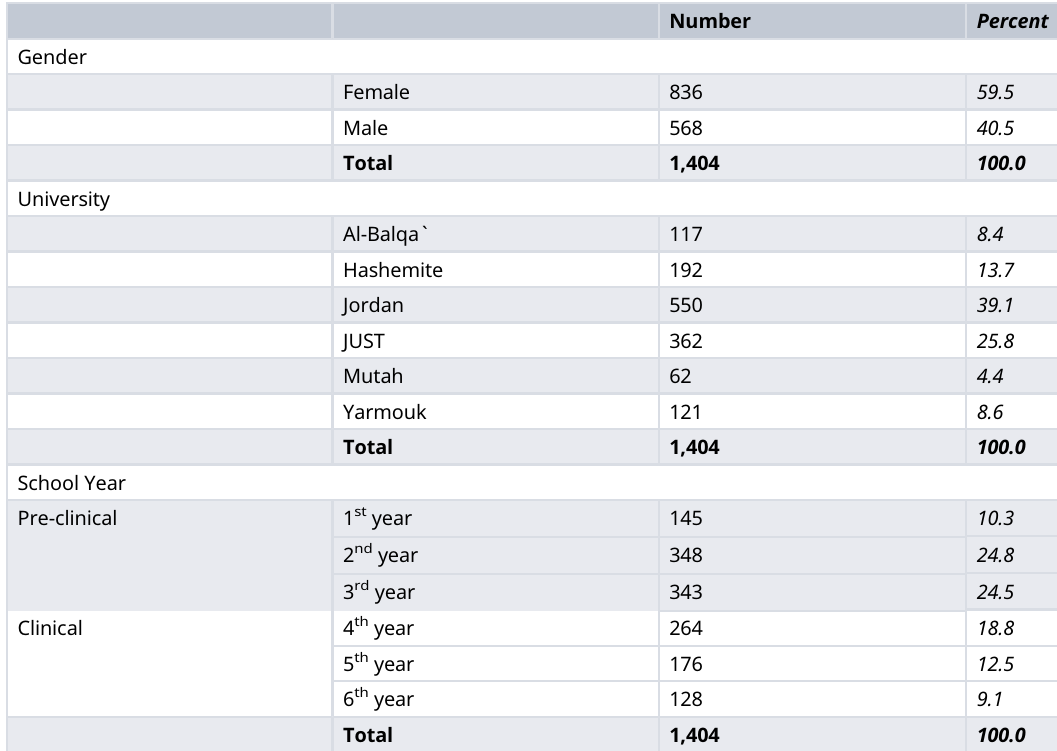
Table 1. Study participants ’ background